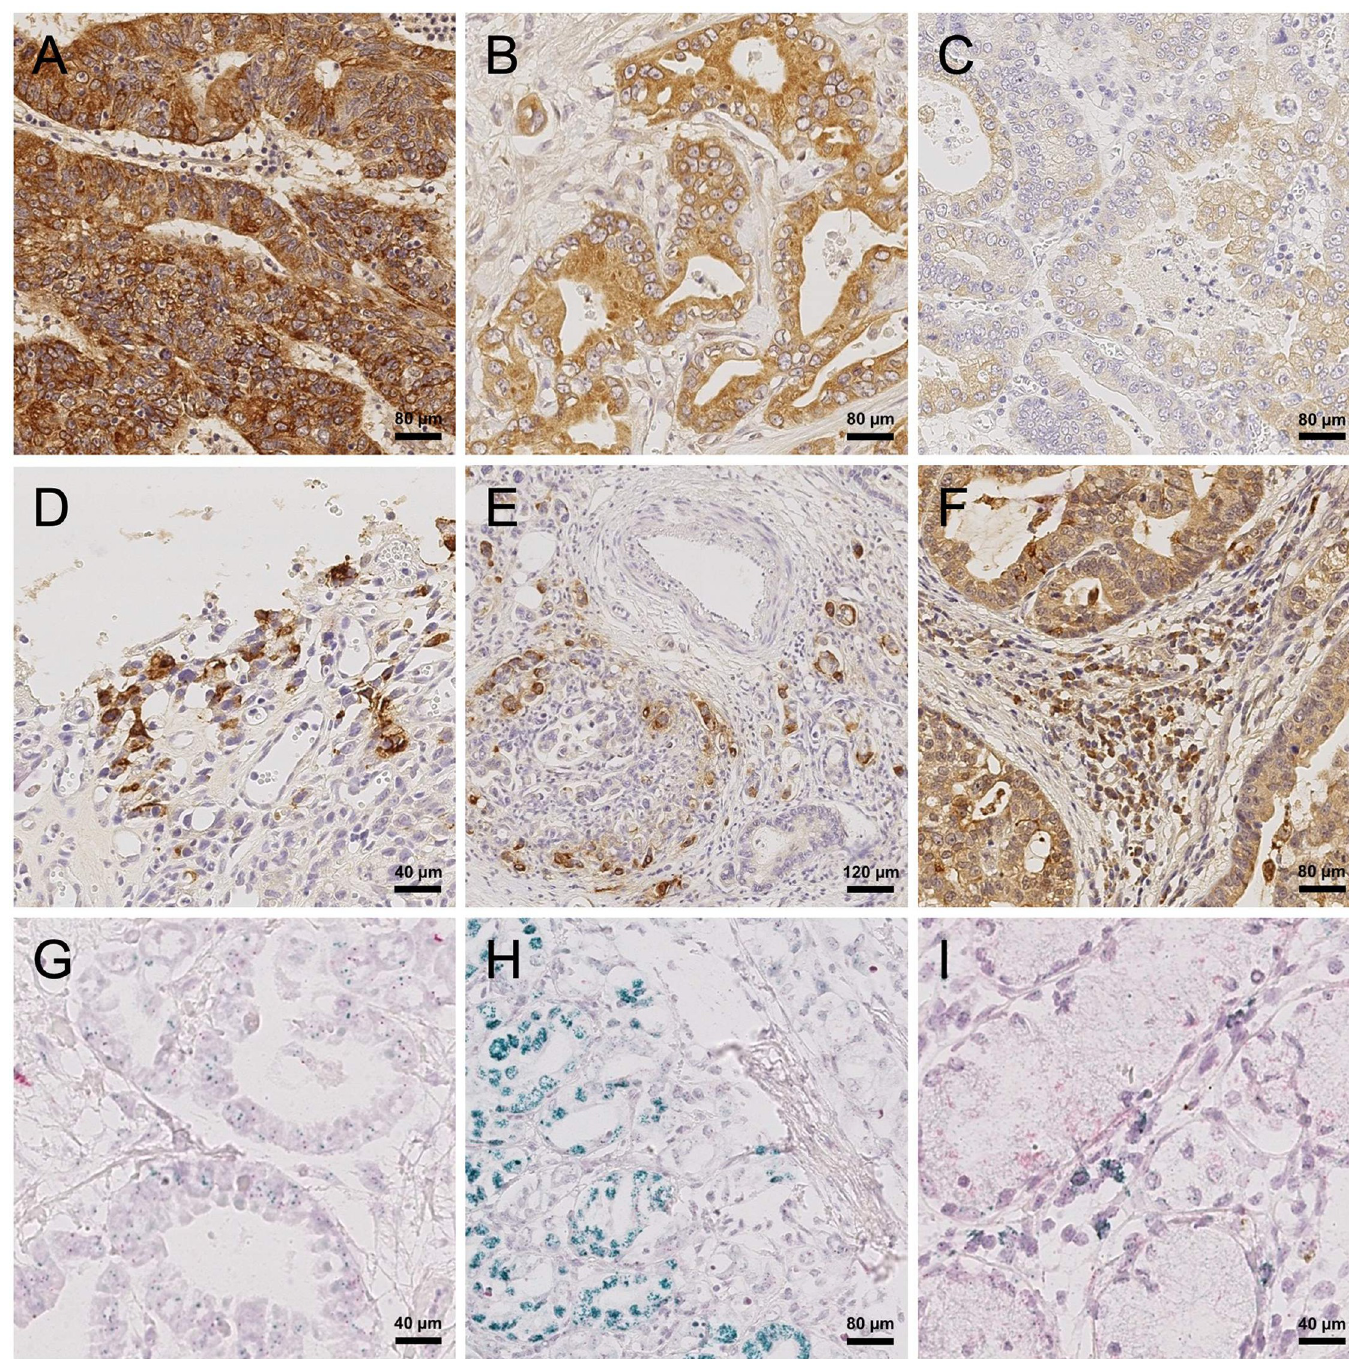
Fig 1. FGFR 2—protein expression and gene amplification in gastric cancer. FGFR2 protein expression was examined by immunohistochemical staining of the FGFR2 receptor. Representative cases with intensity of FGFR-IHC 3 + (A), FGFR-IHC 2 + (B), and FGFR-IHC 1 + (C) were selected and used as reference throughout the study. During immunohistochemical examination of FGFR2, the vast majority of cases with increased FGFR2 protein expression showed a heterogeneous distribution of protein expression (D-E). Strongly FGFR2-positive stromal cells were apparent in 92 (18.5%) cases during the study (F). Sixty cases with strong FGFR2 protein expression were examined for Fgfr2 amplification by chromagenic in situ hybridization. The signals of the Fgfr2 genes showed a green signal, centromere 10 signals a red signal (G). Clusters of Fgfr2 amplifications in tumor cells were found in 18 cases (H). Clusters of Fgfr2 amplifications appeared in close proximity to nonamplified tumor cells (H). Nontumor cells with increased Fgfr2 signals were observed in 14 cases (I). Original magnification: 100 × (E), 200 × (A, B, C, F, H), 400 × (D, G, I).